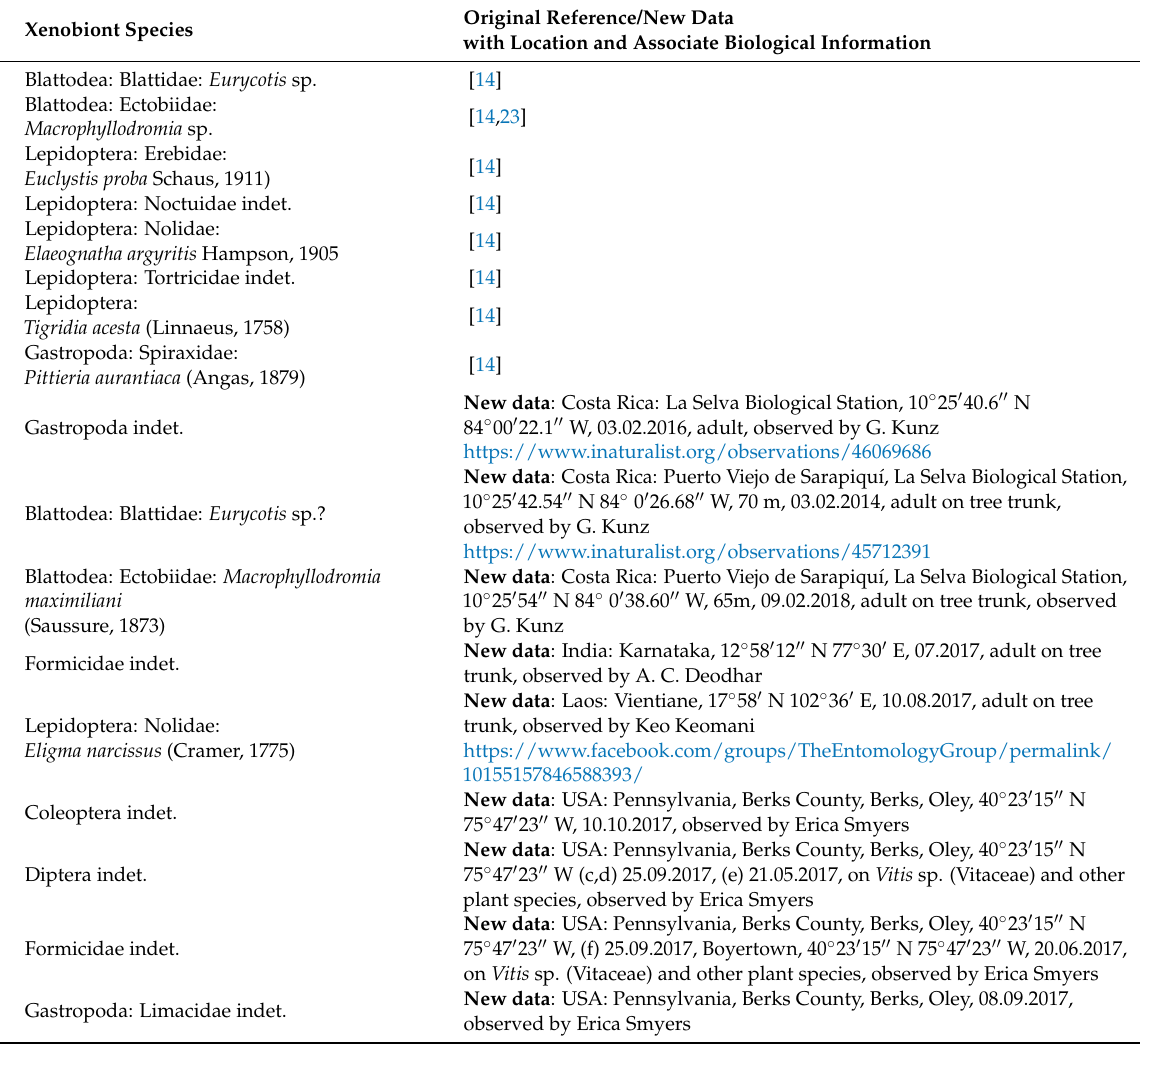
Formicidae indet. Lepidoptera: Nolidae: Eligma narcissus (Cramer, 1775) 23.65 Coleoptera indet.